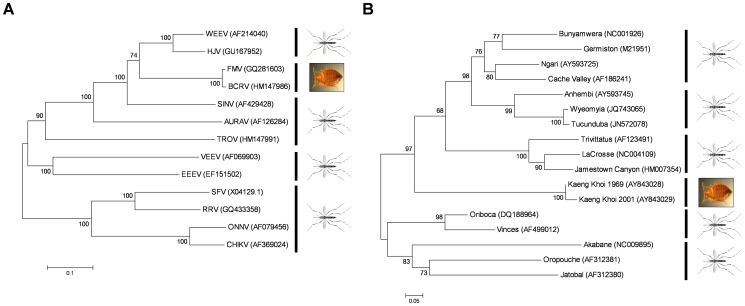
Evolutionary relationships of various mosquito-borne and cimicid-borne viruses.(A) Relationship of the structural proteins E2, 6K, and E1 from the alphaviruses chikungunya virus (CHIKV), o'nyong nyong virus (ONNV), Ross River virus (RRV), Semliki Forest virus (SFV), Trocara virus (TROV), Aura virus (AURAV), Sindbis virus (SINV), Buggy Creek virus (BCRV), Fort Morgan virus (FMV), Highland J virus (HJV), western equine encephalitis virus (WEEV), eastern equine encephalitis virus (EEEV), and Venezuelan equine encephalitis virus (VEEV). (B) Relationship among orthobunyaviruses following alignment of the first ∼100aa of the G2 glycoprotein. Both trees were produced in MEGA5 [31] using the neighbor-joining method; bootstrap support following 2,000 replicates is indicated.